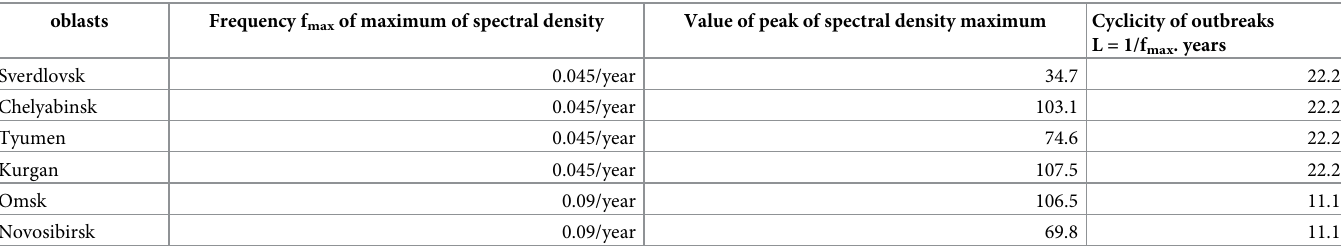
Table 2. The characteristics of spectral density for the time series of square of defoliated forests after L . dispar outbreaks occurred in West Siberia. oblasts